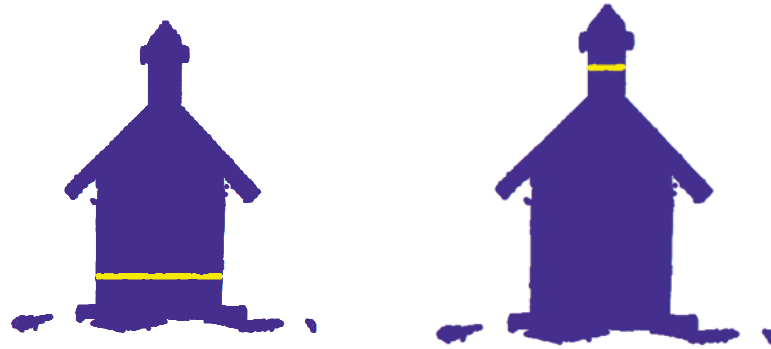
Figure 2. Cross section of the scanned birdhouse obtained from the Geographic Information System. The yellow lines show the position of the two extracted sections for each scan: house body section (B section) on the left and chimney section (C section) on the right.